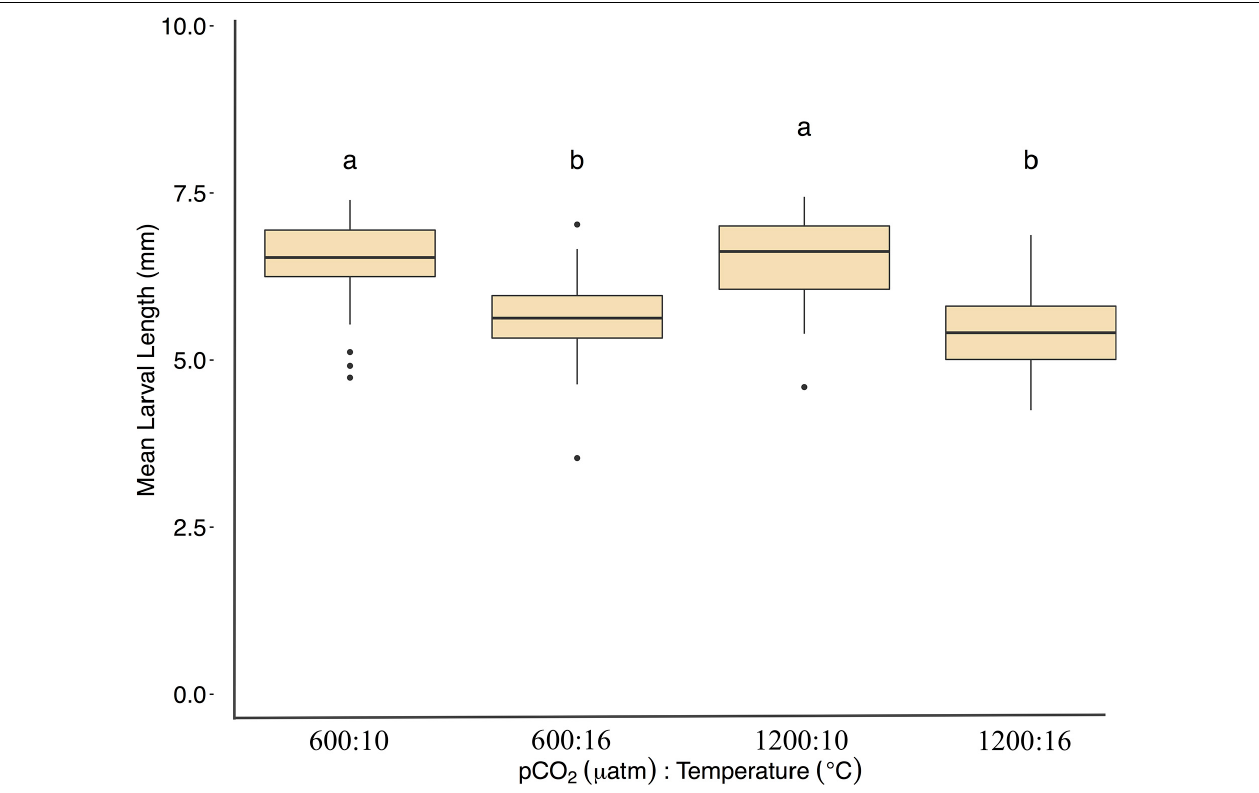
FIGURE 5 | Mean Pacific herring larval lengths (mm) upon hatch. Length data are represented by the mean ± 1 SD of (n) measurements 600 µ atm:10 ◦ C ( n = 414), 1200 µ atm:10 ◦ C ( n = 425), 600 µ atm:16 ◦ C ( n = 338), and 1200 µ atm:16 ◦ C ( n = 271). Lower-case letters indicate statistically different treatments based on a Tukey’s HSD post hoc